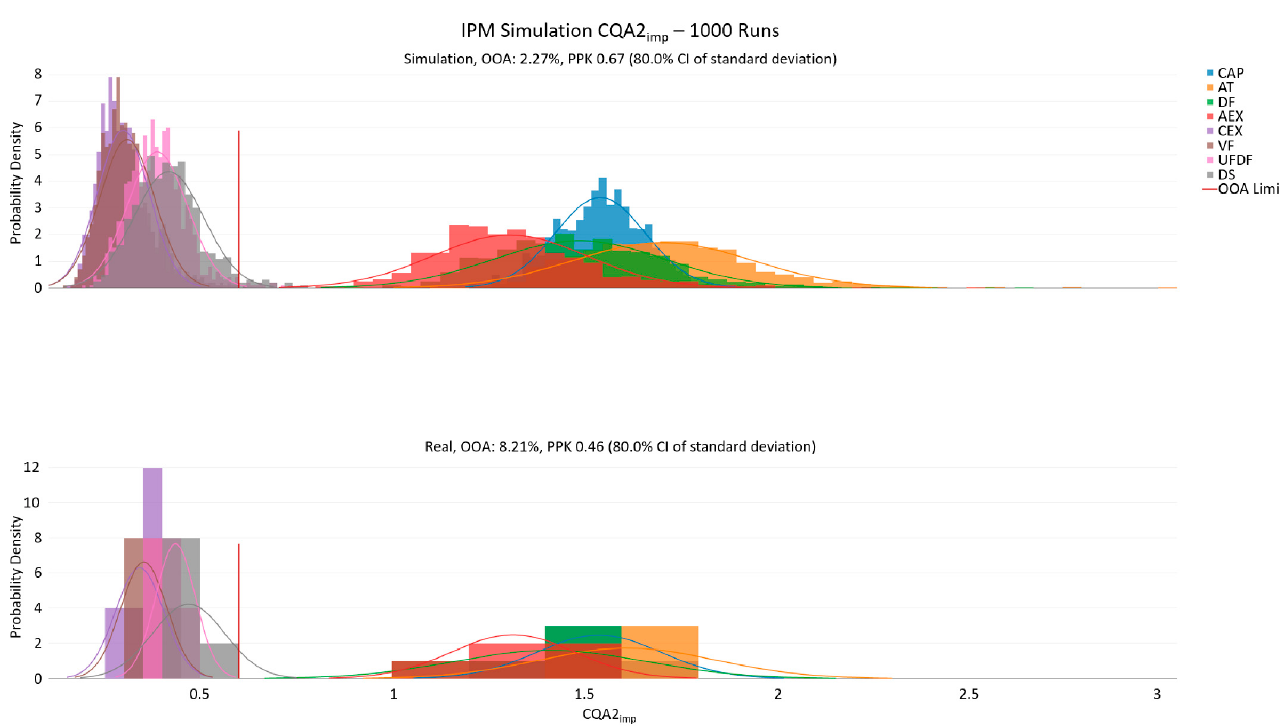
Figure 2. IPM trending plot for 1000 simulations (upper subplot) compared to real data performed (lower subplot) for a CQA impurity. The unit operation order is in descending order in the legend. One can clearly see the descent towards the final drug substance result. The simulation distributions align well with the sparse manufacturing data and the predicted OOA is slightly less than the predicted OOA incidence based on a normal distribution around the real manufacturing data.